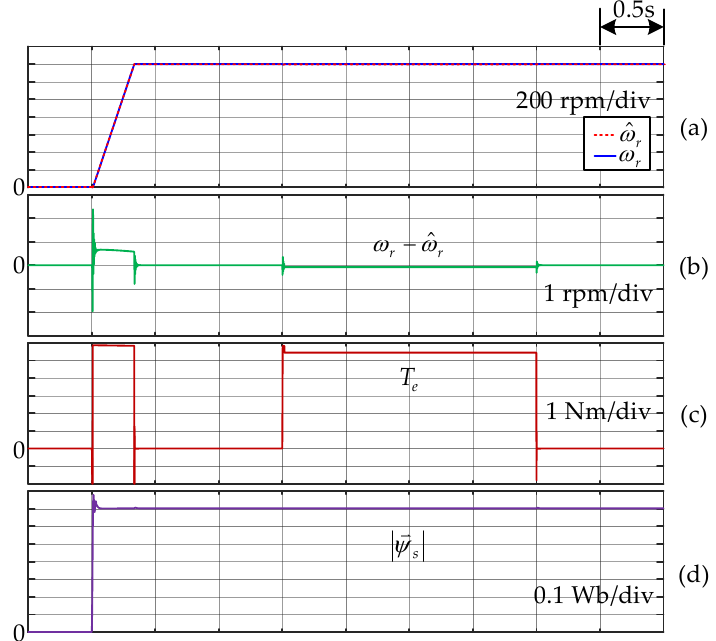
Figure 4. Simulation results when step speed from standstill to 1400 rpm then 100% step-load change ( a ) actual speed response ( ω r ) and estimated speed response ( ˆ ω r ), ( b ) estimation error, ( c ) torque response, ( d ) stator flux magnitude response.